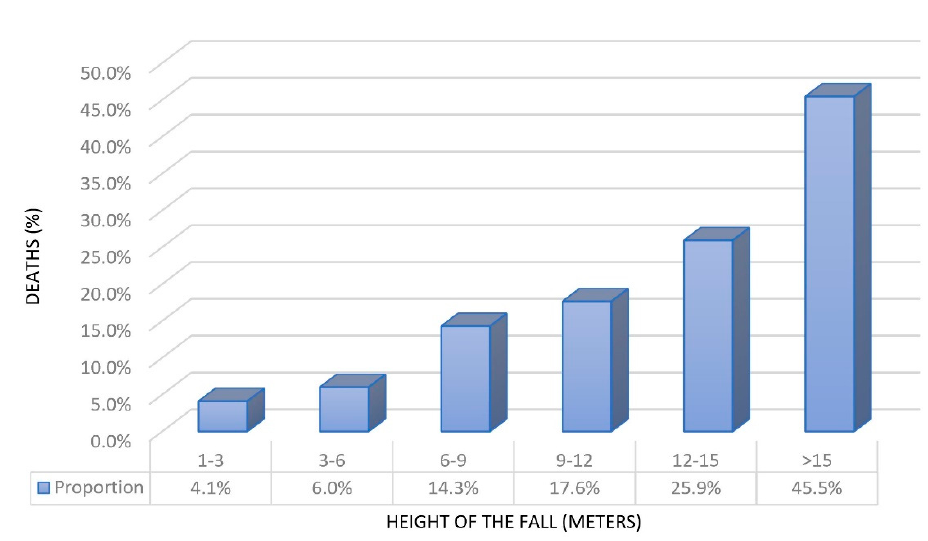
Figure 1. Trend of deaths per clusters of height.